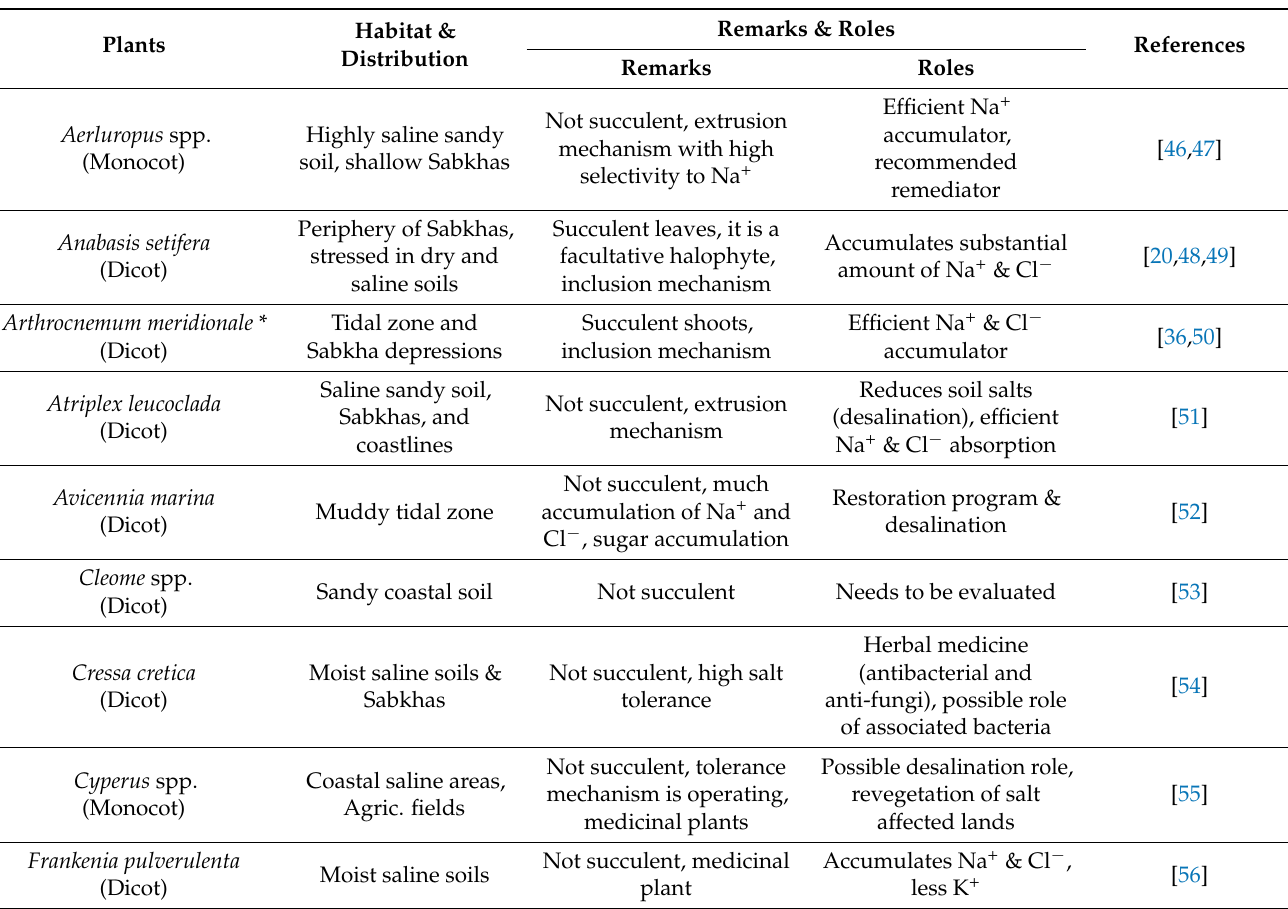
Table 1. Halophyte plants among the flora of Qatar and their ability to absorb and accumulate Na + and Cl −